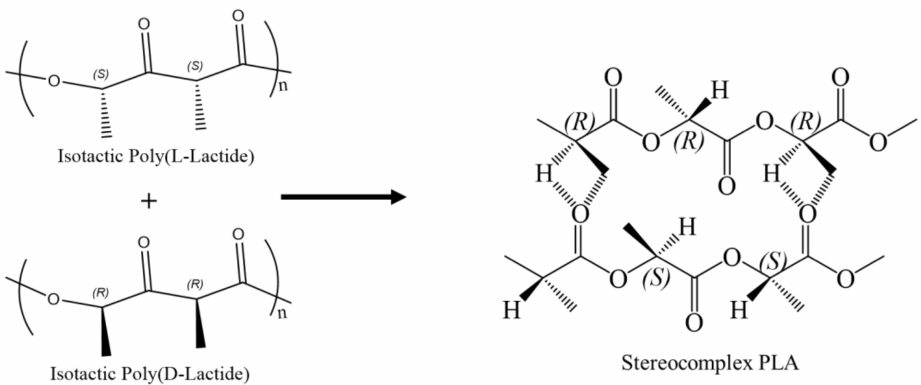
Figure 1. Enantiomeric PLA homopolymers blend to form stereocomplex